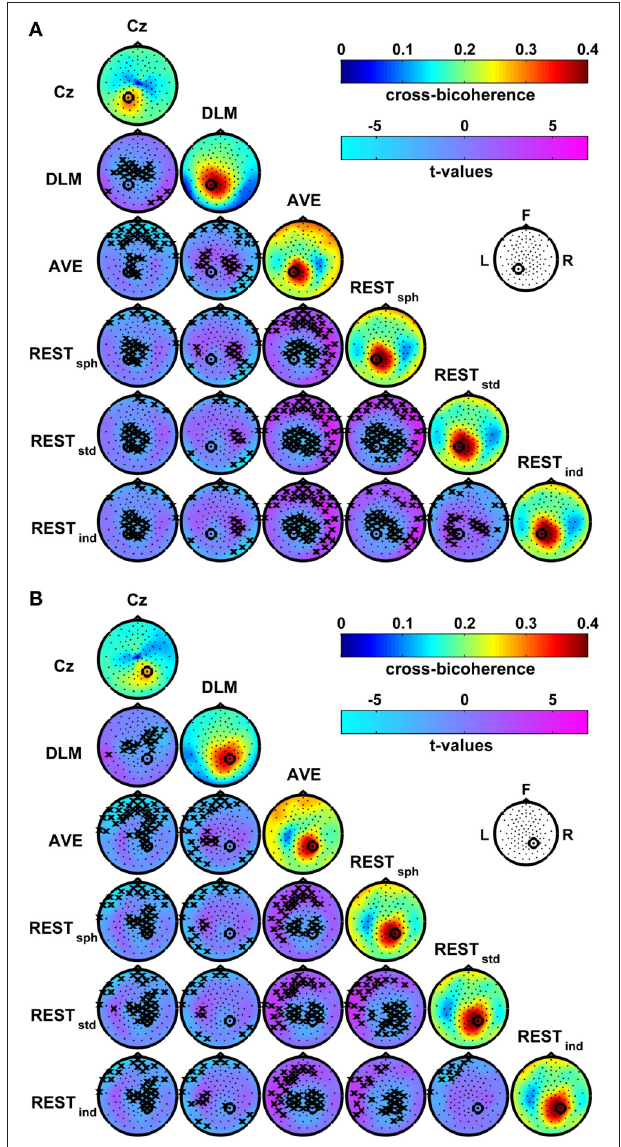
FIGURE 6 | Effects of the EEG reference choice on the estimation of alpha-beta connectivity using cross-bicoherence. Panel (A) : maps of connectivity with seed channel P1. Panel (B) : maps of connectivity with seed channel P2. The seed channels have been marked by a black circle. Main diagonals: maps of the average cross-bicoherence across subjects obtained for the different EEG reference schemes. Off-diagonals: maps of t -values for pairwise contrasts between cross-bicoherence maps from different EEG reference schemes using a paired-sample t -test; the black crosses mark the channels showing significant differences at the p < 0.05 level (two-tailed) based on a permutation test (10,000